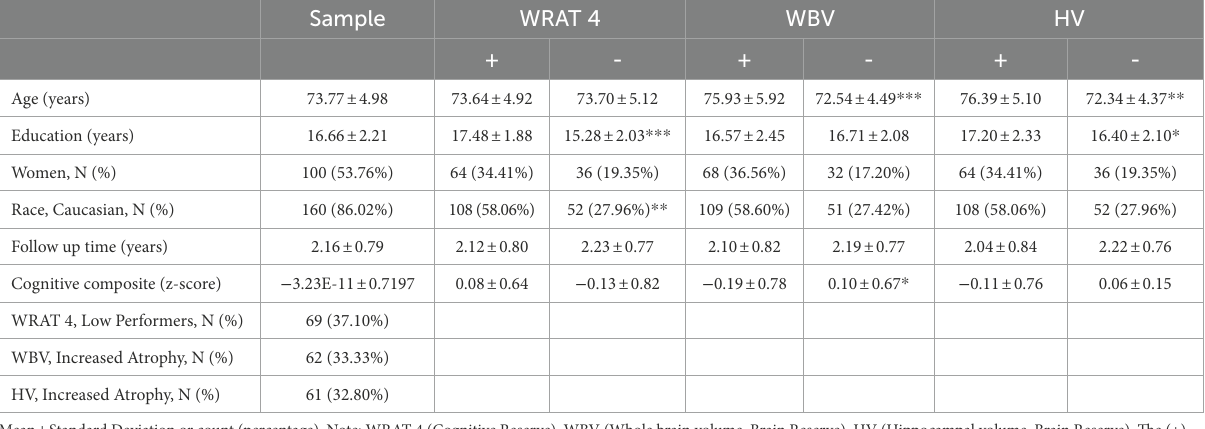
TABLE 1 Baseline demographics ( N = 186) * .